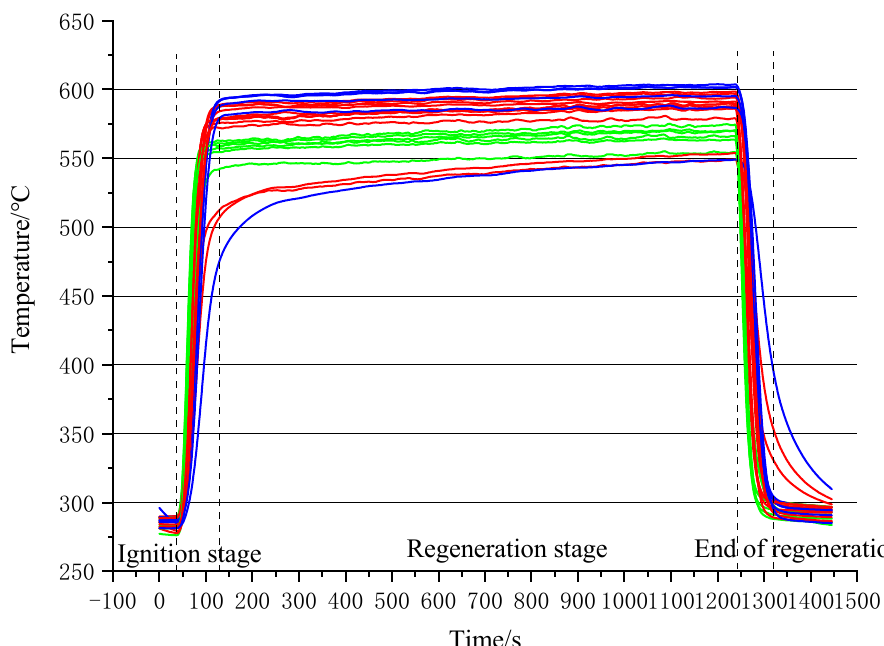
Figure 6. DPF active regeneration internal temperature variation.